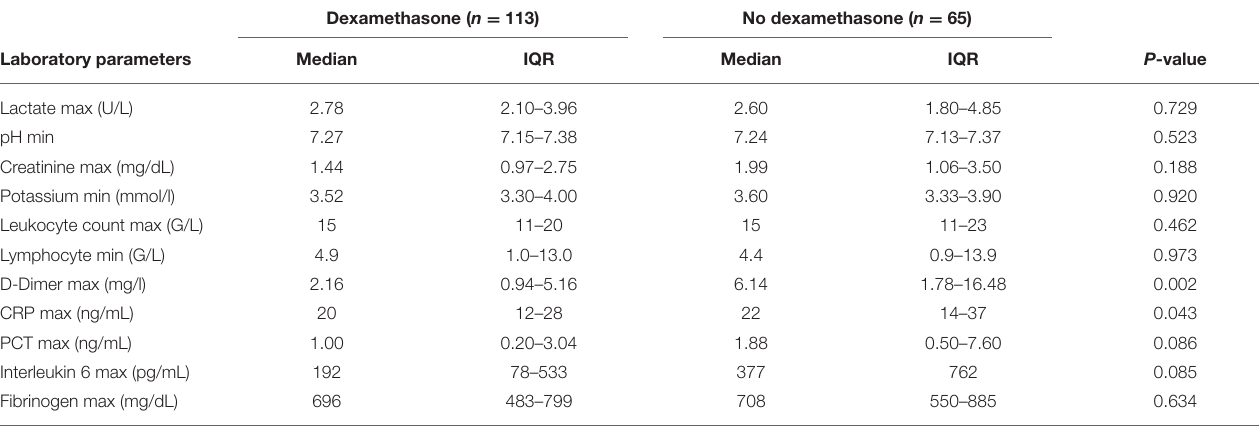
TABLE 3 | Other relevant laboratory parameters in patients of both investigated groups. Dexamethasone ( n = 113)